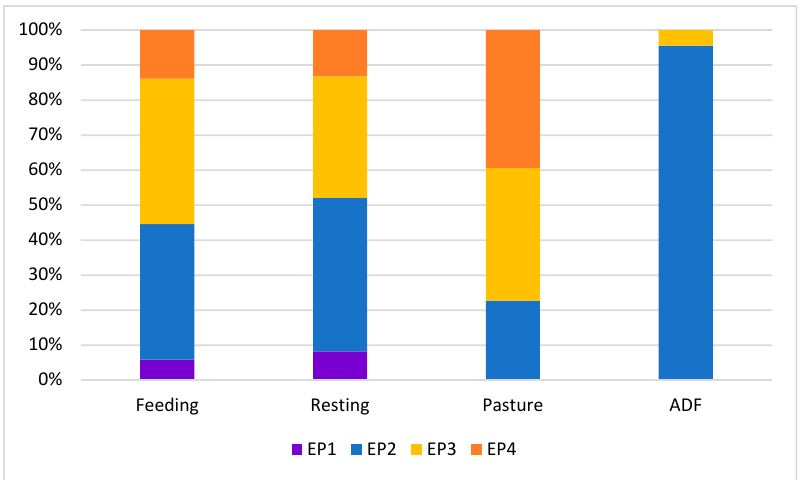
Figure 5. Percentage distribution of the four ear posture classes in each context (feeding, resting, pasture, ADF–avoidance distance test at the feeding rack).